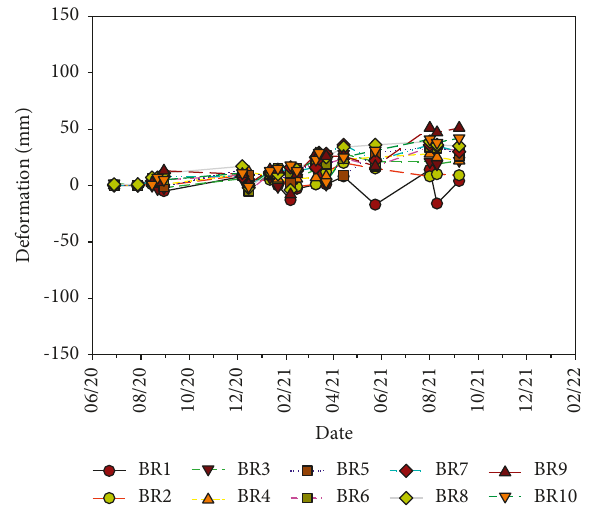
Figure 21: A time series of the change in deformation along the right